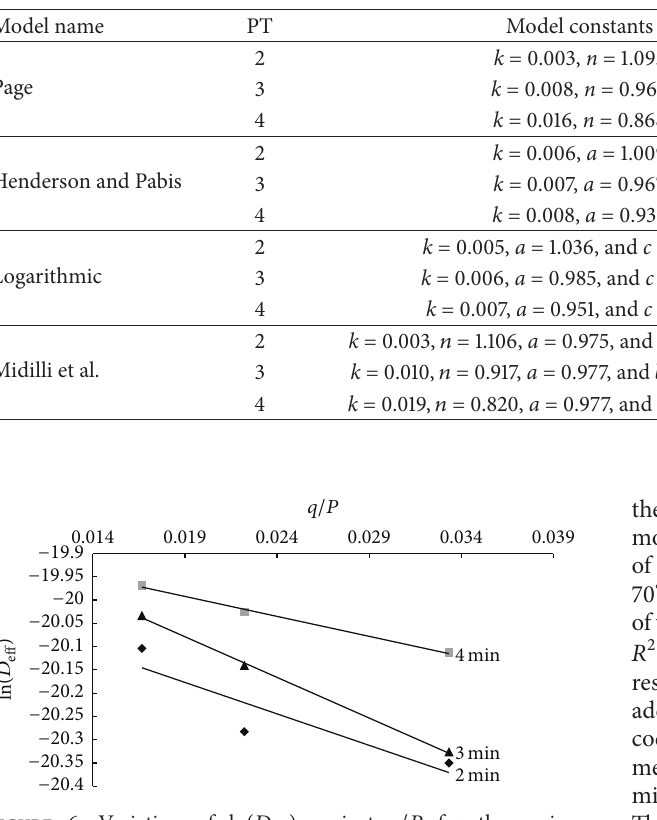
Table 5: Parameters and statistical results for the various drying models for microwave pretreated samples at 450 W.